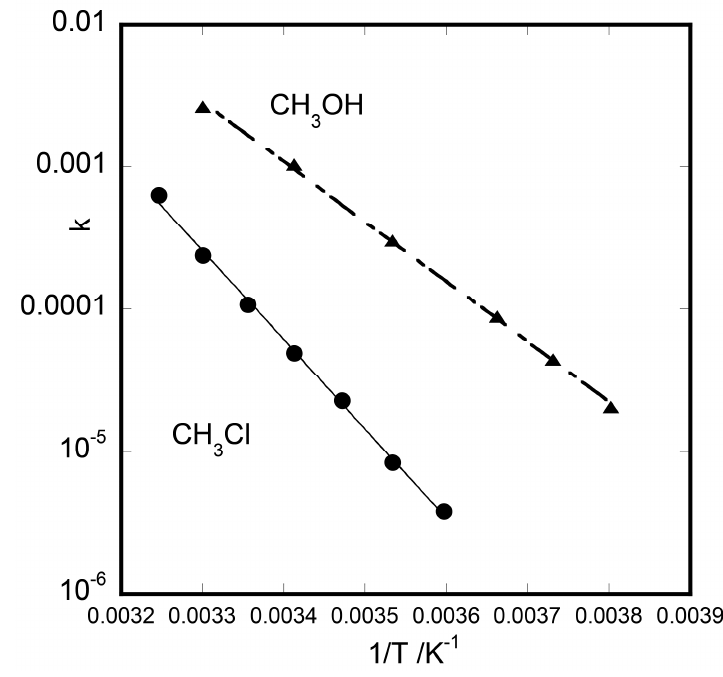
Figure 3. The Arrhenius plots of epimerization rate constants of [{ Λ -Ru(III)(acac) 2 (taet)} 3 Al(III)] in CH 3 OH or CH 3 Cl as